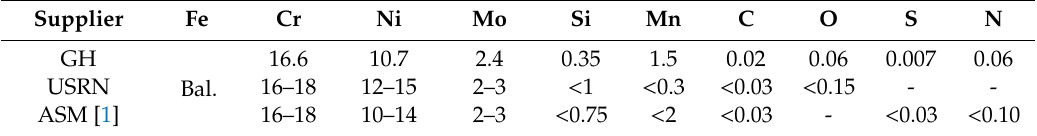
Table 1. Composition of powders reported by the vendor